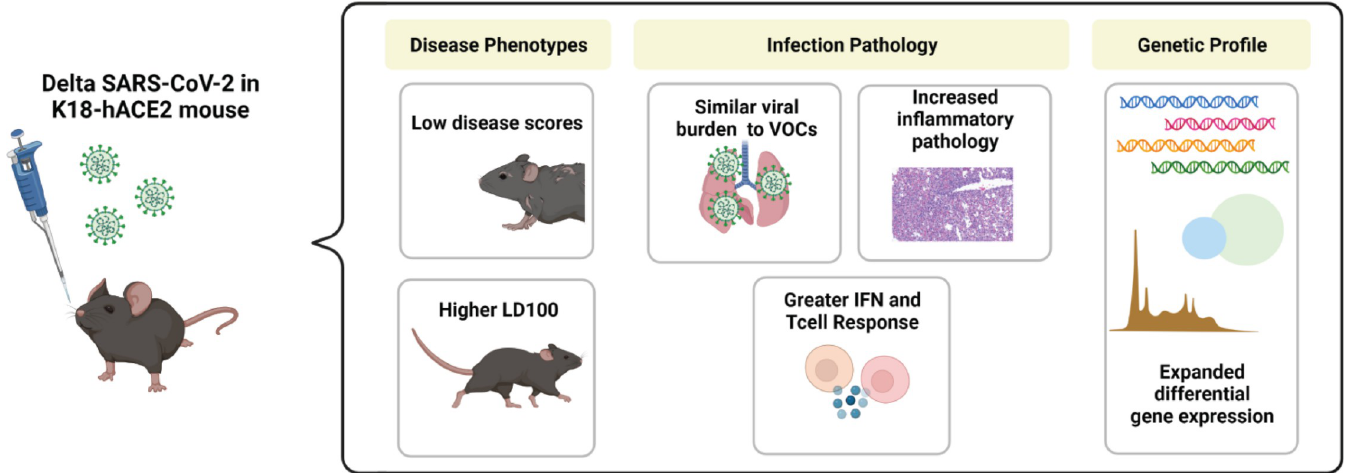
Fig 9. SARS-CoV-2 Delta variant challenge in the K18-hACE2 transgenic mouse model. Male, 8 week-old K18-hACE2 transgenic mice were intranasally challenged with 10 3 PFU Delta SARS-CoV-2 and the host response to virus was analyzed at 2 and 6 days post-challenge. Delta challenge results in attenuated disease scores compared to previous VOC, and extended survival time at this dose. Despite similar viral RNA burdens, Delta-challenged mice experience greater inflammatory pathology in the lung with an expanded differential gene expression profile suggestive or greater interferon and T cell responses.